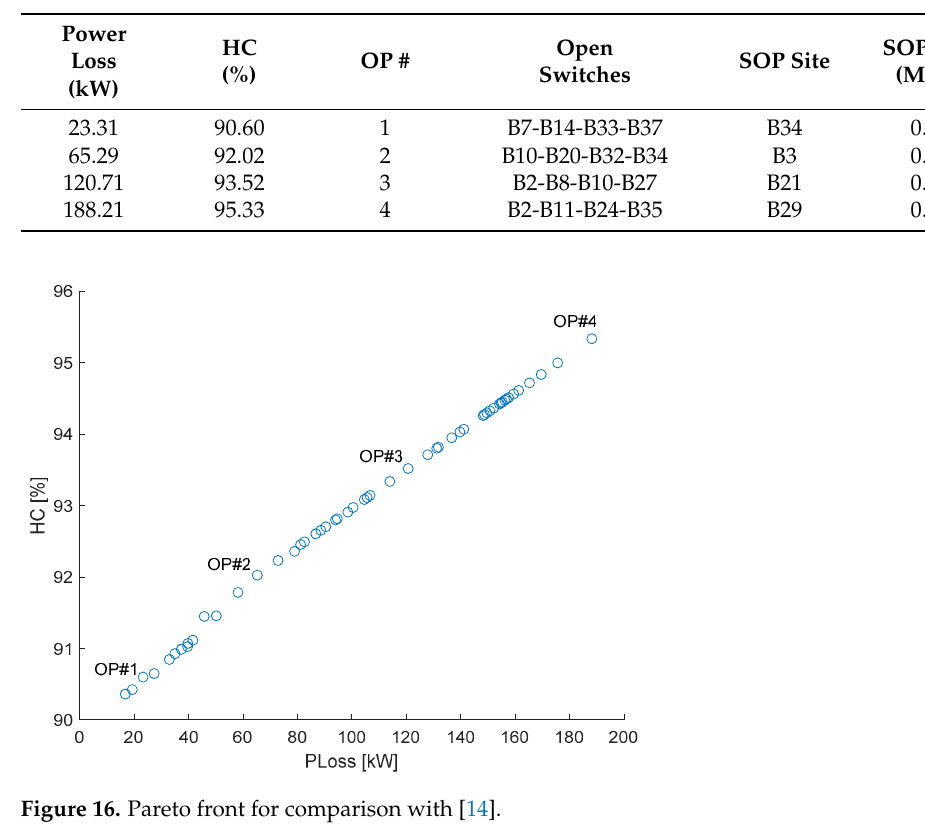
Table 11. Nondominated solutions from MOAIS, comparison with [14].